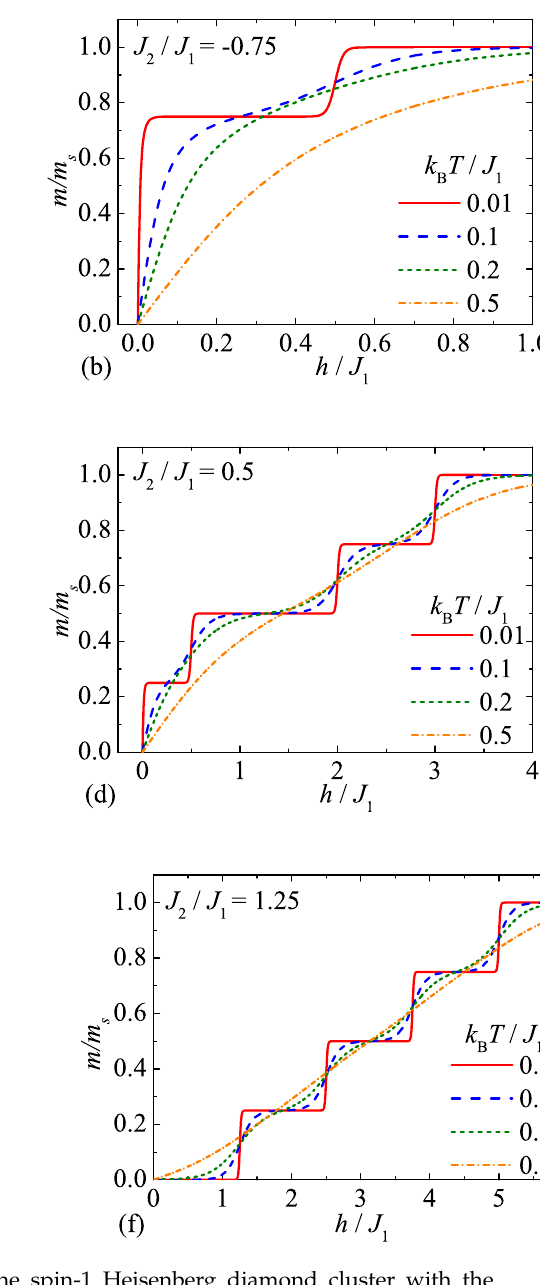
Figure 4. Isothermal magnetization curves of the spin-1 Heisenberg diamond cluster with the antiferromagnetic coupling constant J 1 > 0 along its shorter diagonal for four different values of temperature and a few selected values of the interaction ratio: ( a ) J 2 / J 1 = − 1.25; ( b ) J 2 / J 1 = − 0.75; ( c ) J 2 / J 1 = 0.25; ( d ) J 2 / J 1 = 0.5; ( e ) J 2 / J 1 = 0.75; ( f ) J 2 / J 1 = 1.25. The magnetization is normalized with respect to its saturation value m s